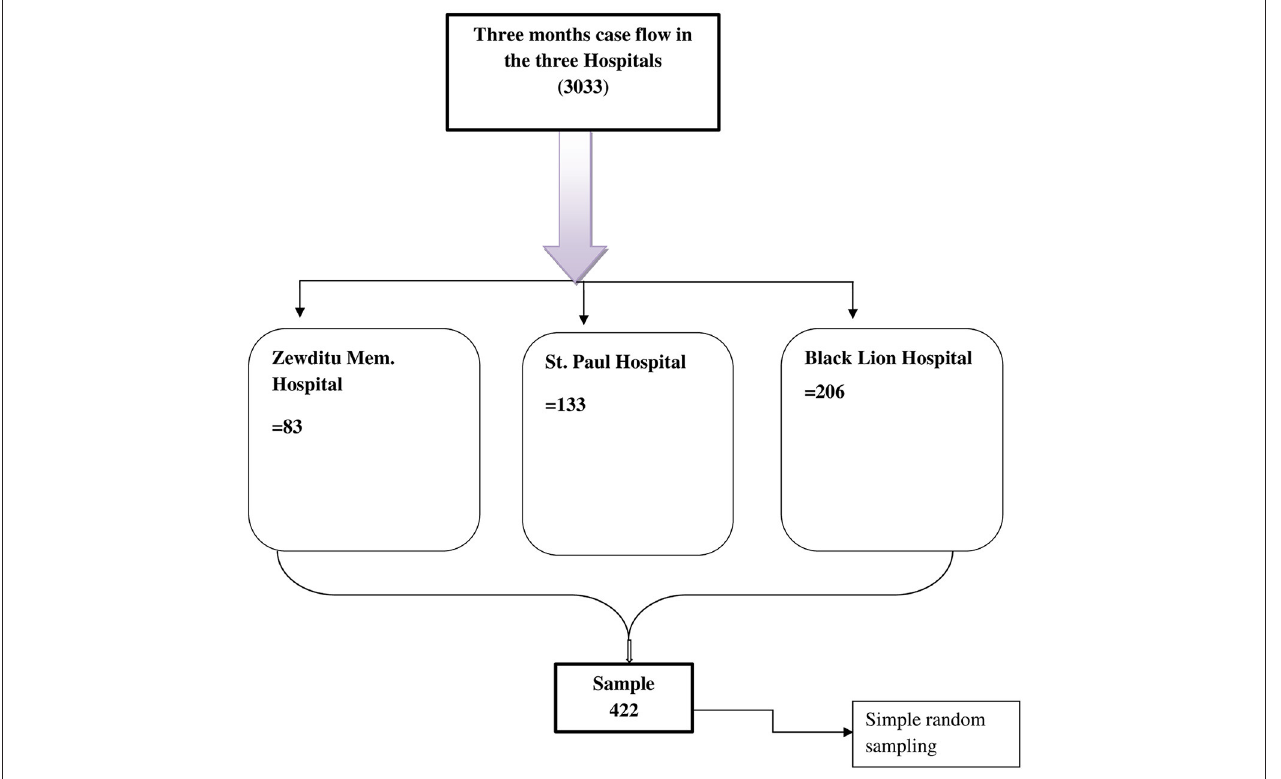
FIGURE 1 | Schematic representation of the sampling procedure,